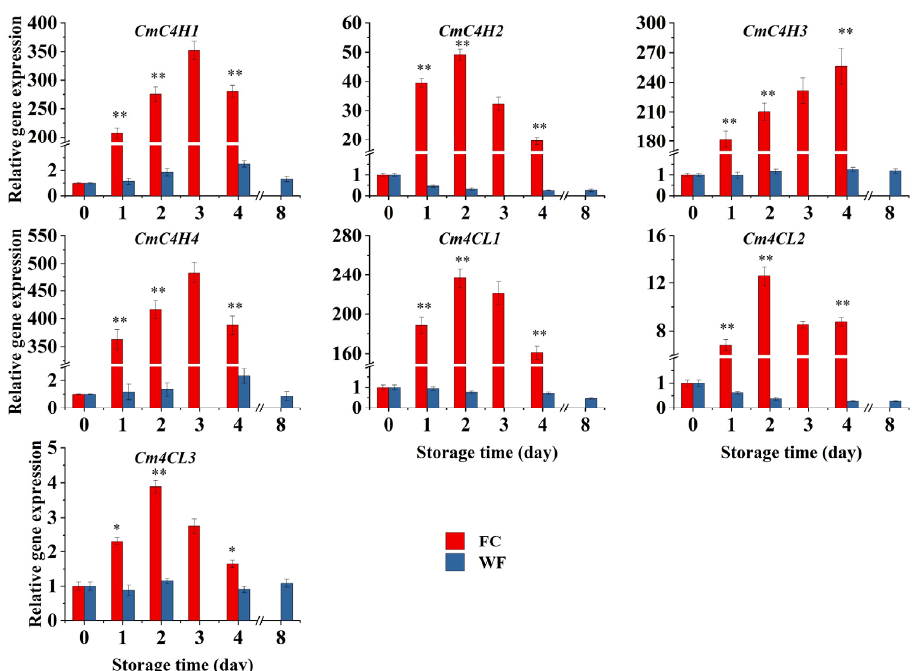
Figure 6. Effect of cutting on the relative gene expressions of cinnamate-4-hydroxylase ( CmC4H1/2/3/4 ) and 4-coumarate-CoA ligase ( Cm4CL1/2/3 ) in melon fruit during storage (15 °C). FC and WF respectively represent fresh-cut and whole melon fruit. The values are expressed as means ± SE of three replicates. * and ** indicate statistically significant differences ( p ˂ 0.05 and p ˂ 0.01 respectively) according to Student’s t -test at each sampling point.